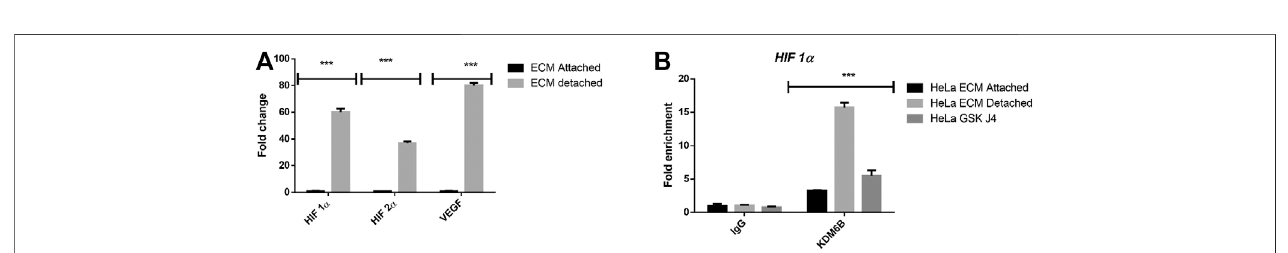
FIGURE 4 | Matrix detachment induces the hypoxia-regulated KDM6B expression and activity. (A) mRNA expression of various stemness-related genes HIF1 α , HIF2 α , and target gene VEGF in HeLa cell lines during matrix detachment for six days. The values were normalized with the housekeeping gene RPLP0 , and other gene expressionvalueswerecalculated. (B) EnrichmentofKDM6BonthepromotersofHIF1 α bothinthepresenceandabsenceofGSKJ4(5 µM)inHeLacellsduringmatrix detachment for six days; nonimmune IgG was used as the input control. ** p .value > 0.001, * p .value > 0.01, *** p .value >